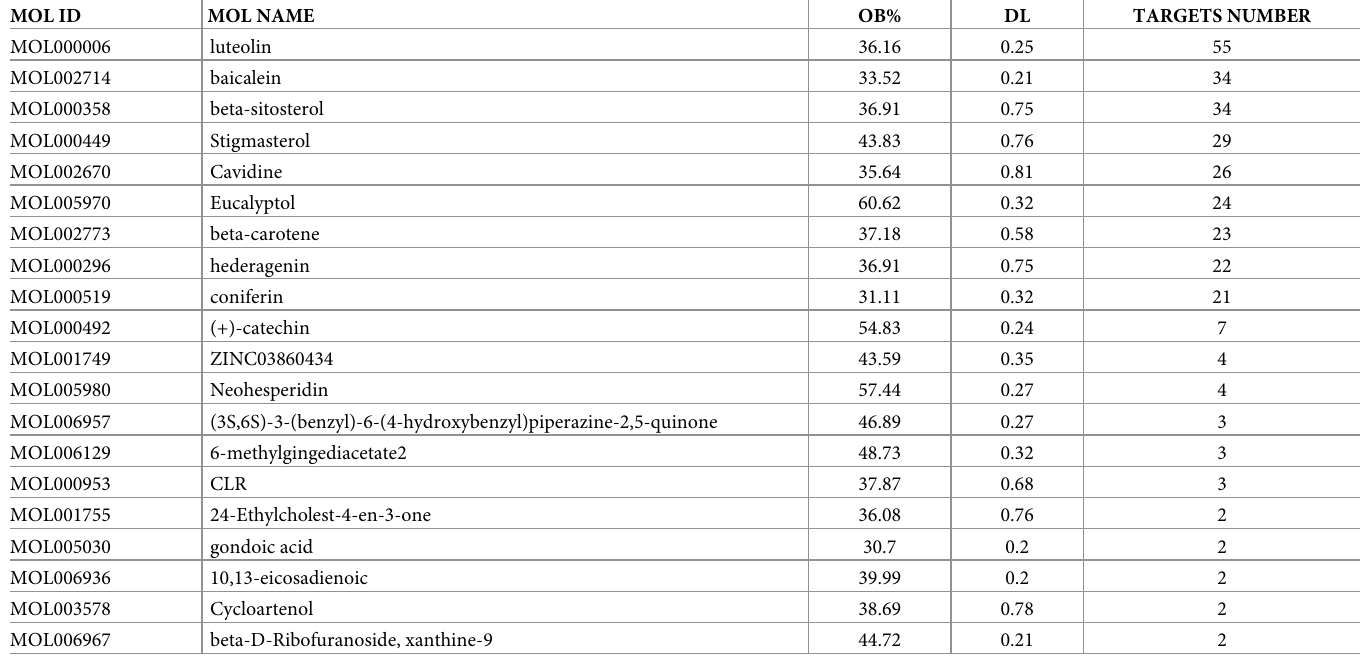
Table 1. Basic information of active compounds of